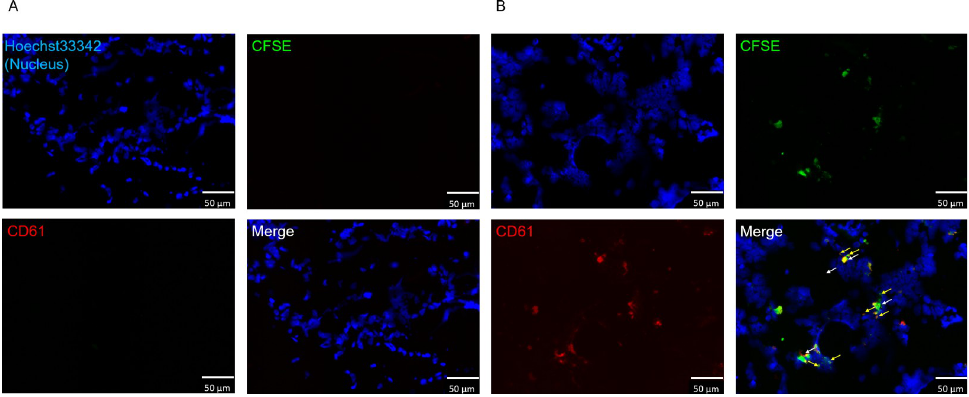
Fig 4. Immunohistochemical staining of thighbone using in vivo production system (A) with or (B) without megakaryocytes introduction. The properties of platelet-like cells produced by the in vivo production system were evaluated by immunohistochemical staining of the porcine thighbone. White arrows indicate introduced megakaryocytes while yellow arrows indicate CFSE-labeled, CD61+ platelet-like cells. Hoechst33342, CFSE, and anti-CD61 antibody are shown in blue, green, and red,